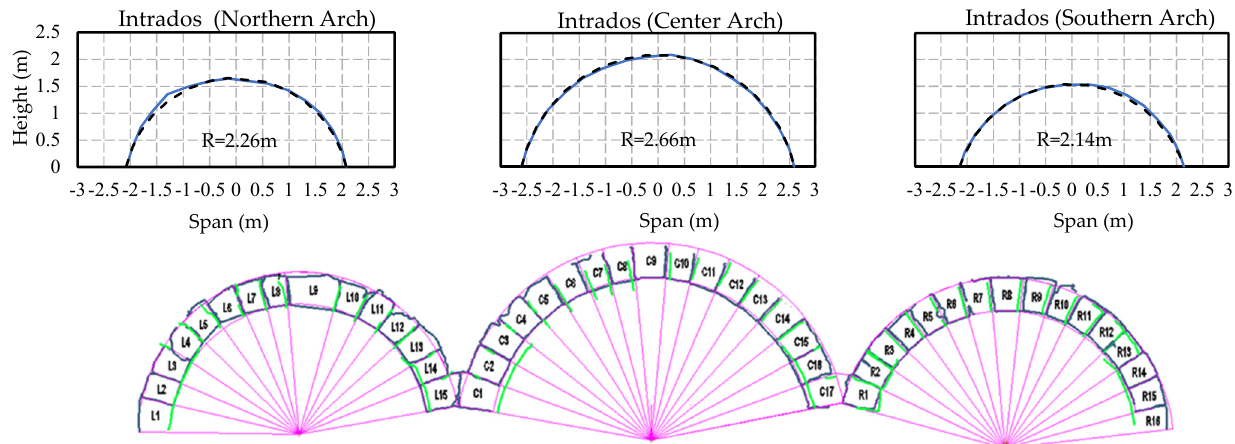
Figure 7. Measured arch geometry and estimated mathematical forms (blue: downstream measurement, green: upstream measurement, pink: semi-circle fit).